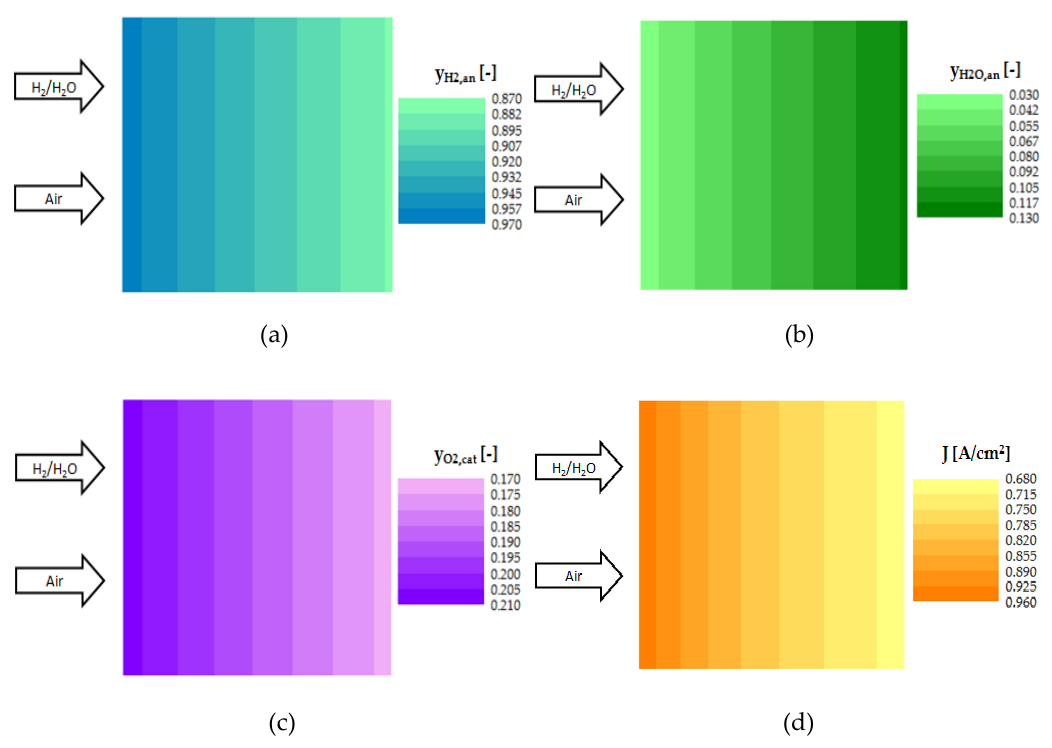
Figure 4. Maps in co-flow feeding configuration at inlet conditions of 1023 K with H 2 /H 2 O 97/3 and air: ( a ) H 2 , ( b ) H 2 O, ( c ) O 2 molar fraction [-], ( d ) current density [A/cm 2 ] in Pt-mesh+LSCF cell.